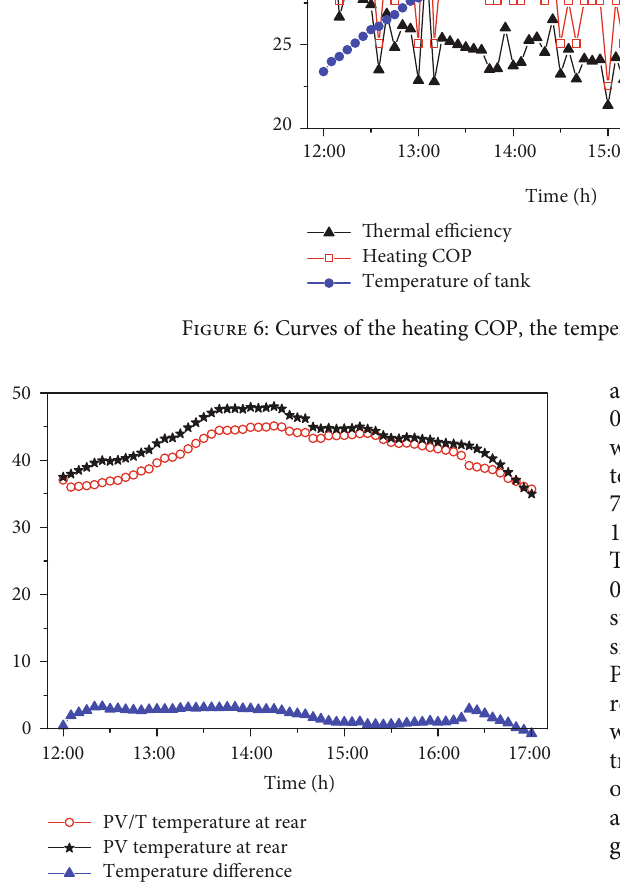
Figure 7: Temperature variation of di ff erent